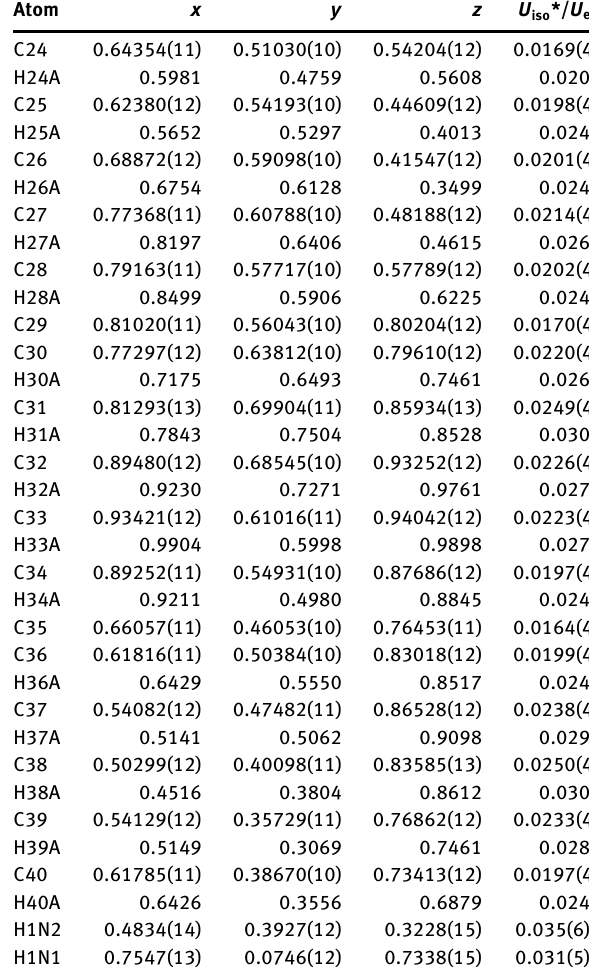
Table 2: Fractional atomic coordinates and isotropic or equivalent isotropic displacement parameters (Å 2